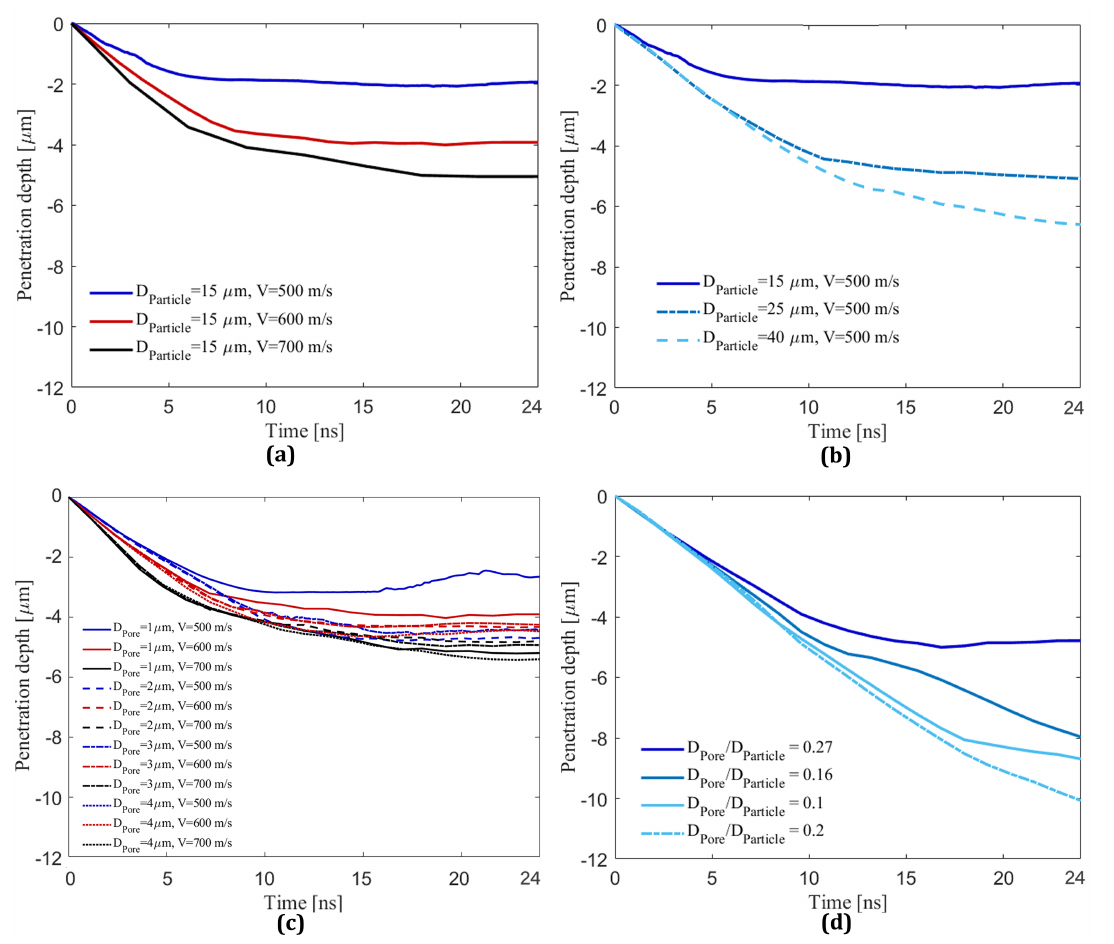
Figure 4. The penetration depth of the B 4 C particle in an Al substrate vs. time for varying impact velocities, particle size, and pore sizes: ( a ) The penetration depth of the particle with D Particle = 15 µ m for V Impact = 500, 600, and 700 m/s. ( b ) The penetration depth of the particles with D Particle = 15, 25, and 40 µ m and V Impact = 500 m/s. ( c ) The penetration depth vs. time for D Particle = 15 µ m at V Impact = 500, 600, and 700 m/s on the substrate including a pore with D Pore = 1, 2, 3, and 4 µ m placed at a depth of 0.4 D Particle . ( d ) The penetration depth of particle with D Particle = 15, 25, and 40 µ m and V Impact = 500 m/s on the substrate with D Pore = 4 and 8 µ m placed at a depth of 0.4 D Particle . The curves associated with D Pore of 0.27, 0.16, 0.1, and 0.2 correspond to D Pore D Particle 8 , 40